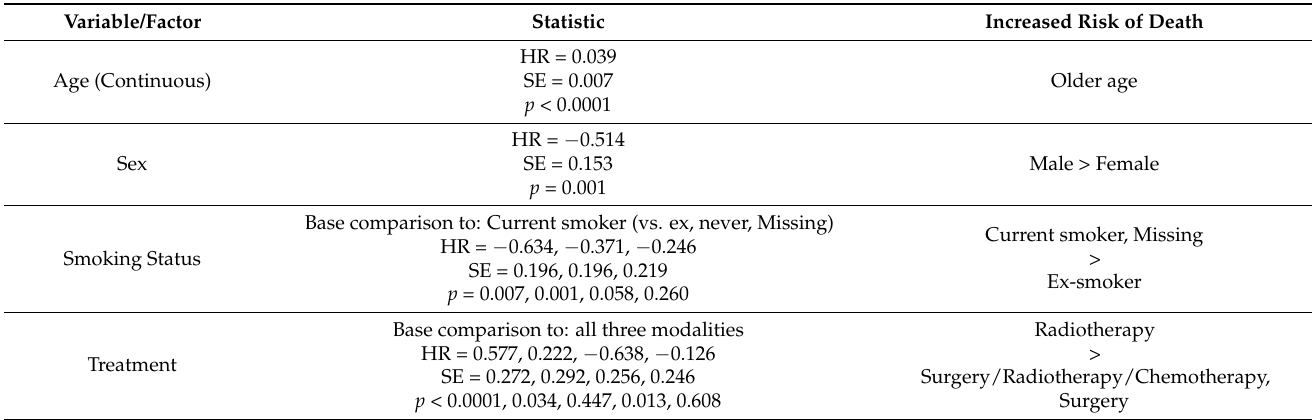
Table 8. Patient and tumor characteristics significantly predicting overall survival amongst oral cavity cancer patients by multivariable Cox proportional hazard model ( n =